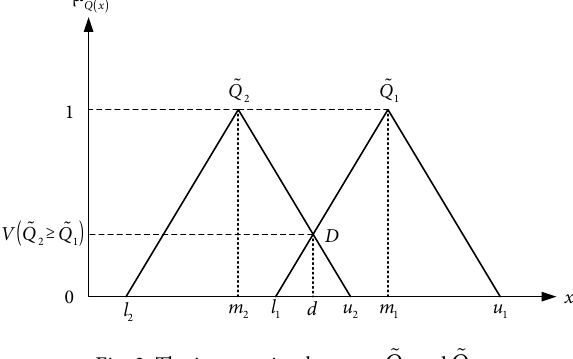
Fig. 2. The intersection between 1 Q